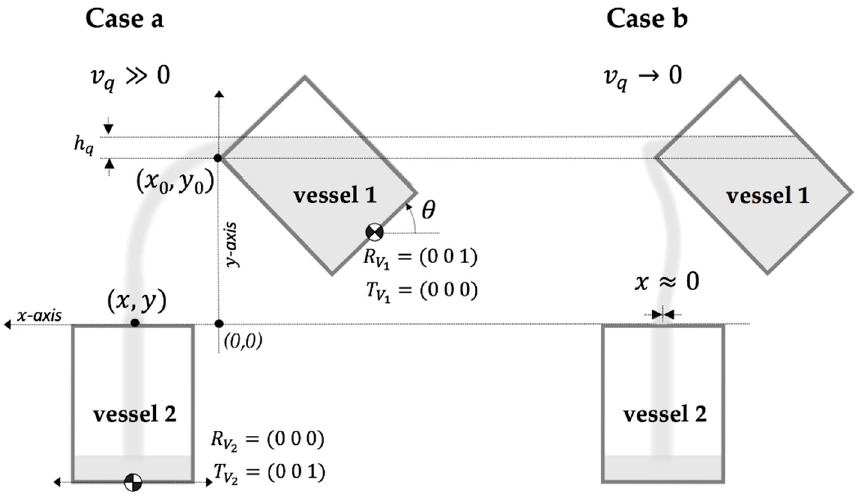
Figure 1. Case a. Expected laminar flow with free fall trajectory slope. Case b. Unexpected no-slope Figure 1. Case ( a) . Expected laminar flow with free fall trajectory slope. Case ( b) . Unexpected no-slope turbulent fall turbulent fall trajectory.